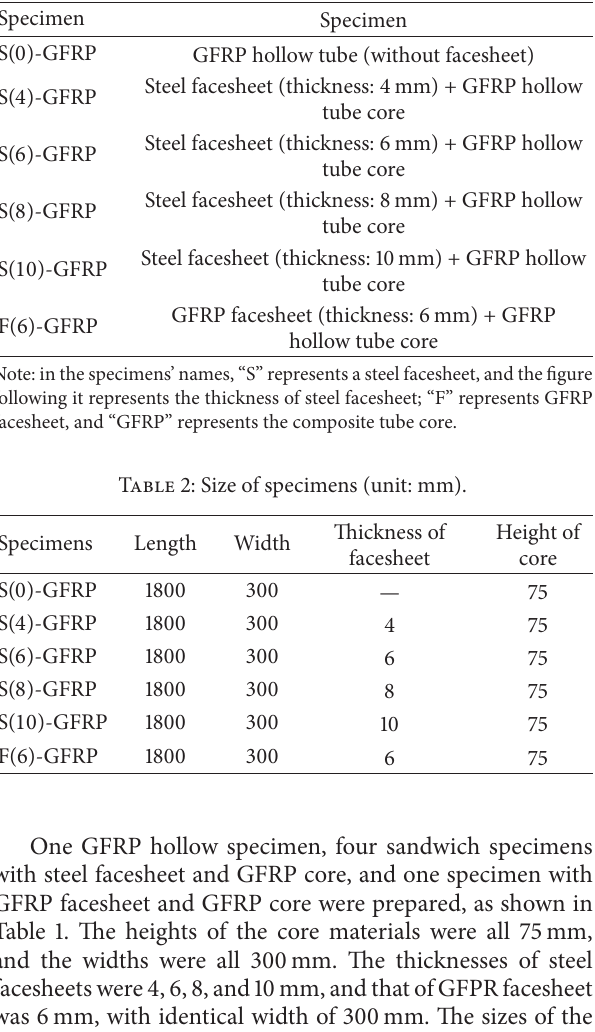
Figure 1: Schematic of the sandwich panel. Table 1: Description of specimens of steel-GFRP sandwich panels.